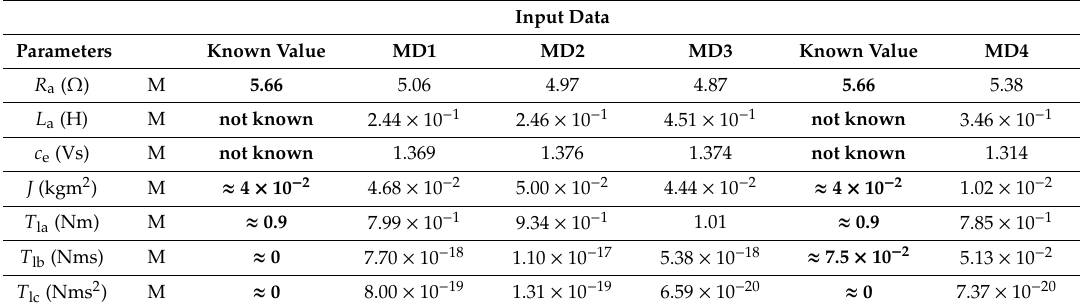
Table 17. Mean values of calculated parameters for 50 independent runs using DE/rand/1/exp and RK for all input data.